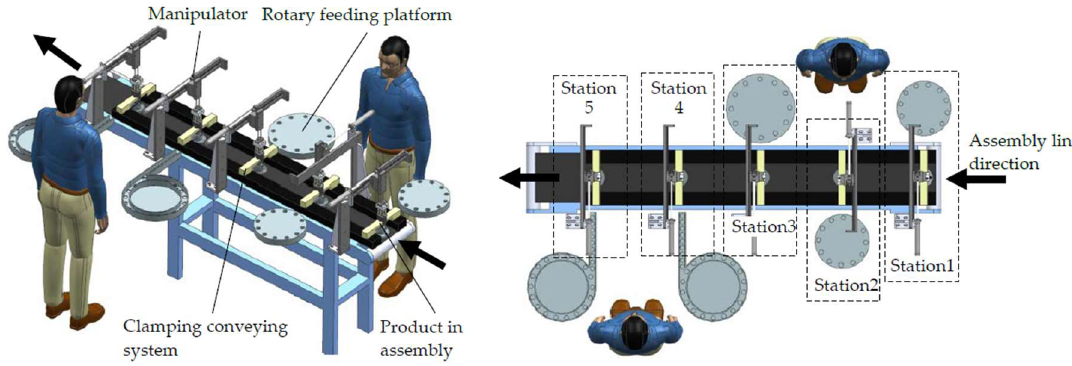
Figure 2. The automatic assembly system.